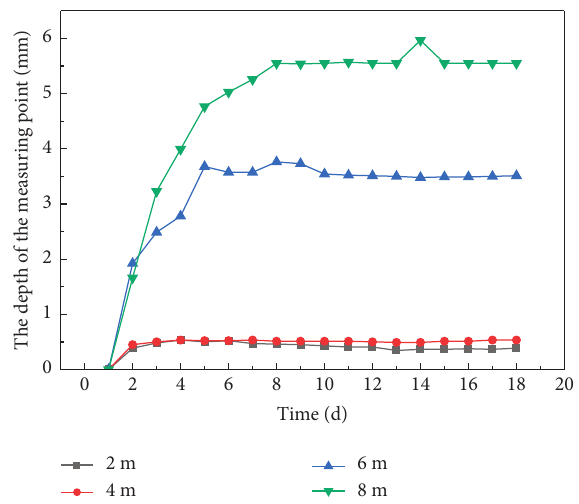
Figure 9: Law of variation in the surrounding rock displacement with time at different depths.